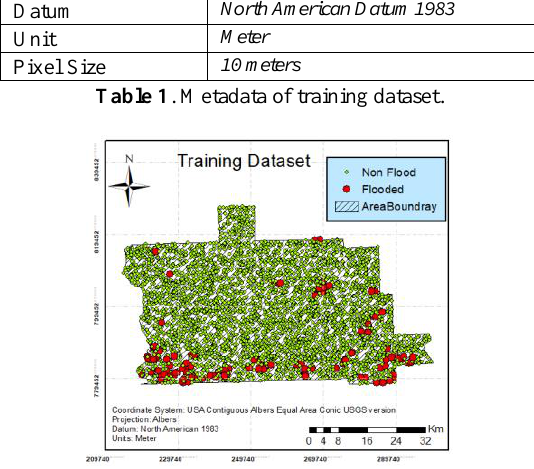
Figure 6 . The obtained training data flooded and non-flooded